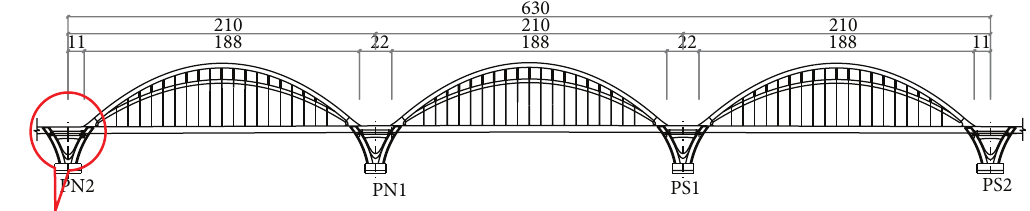
Figure 1: Layout of longitudinal section of bridge